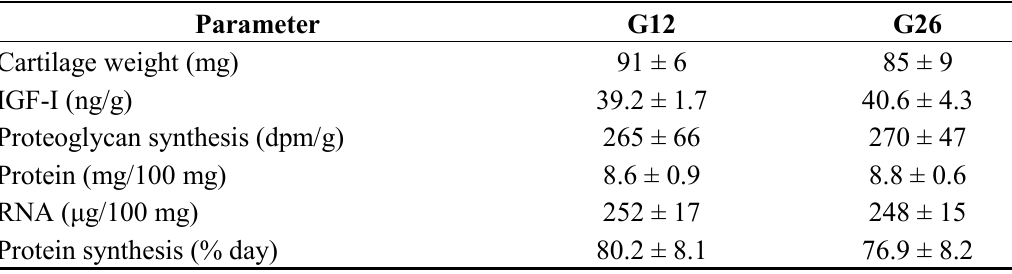
Table 5. Growth and protein synthesis in cartilage tissue 1,2 .